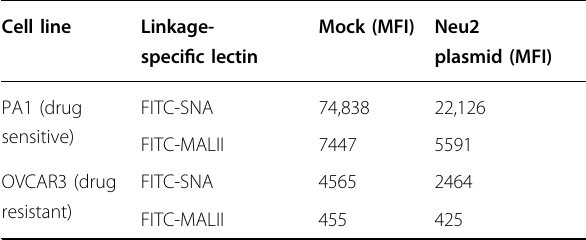
Table 1 Sialylation status of ovarian cancer